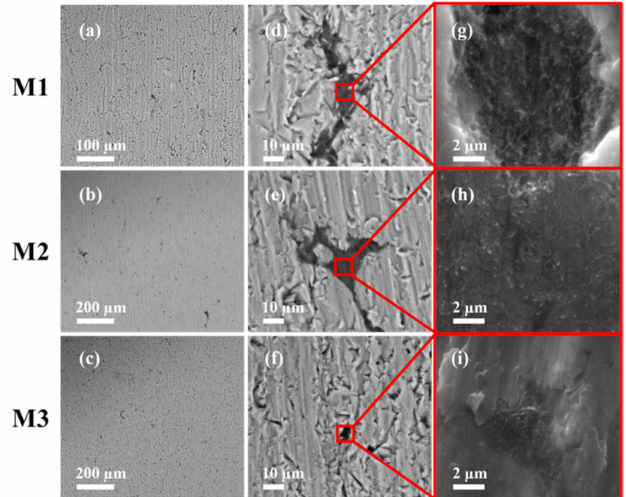
Figure 2. Cross-sectional BSE-SEM ( a – c ) for sintered Al-based MWCNTs nanocomposites M1, M2 and M3. Despite the good dispersion of the MWCNTs, images ( d – f ) show some MWCNTs agglomerations along the samples cross section. SE-SEM micrographs ( g – i ) confirm the appearance of MWCNTs clusters which is an indication that carbon nanotubes dispersion was not